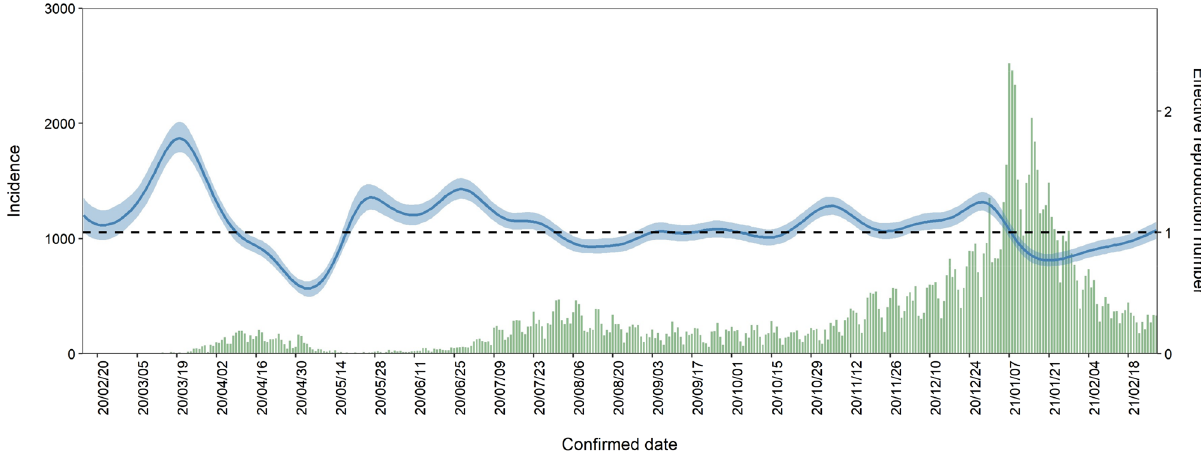
Figure 1. Transmission dynamics from 15th February 2020 to 28th February 2021 in Tokyo, Japan. Blue line represents median, blue shading represents 95% credible intervals of the estimated effective reproduction number from 15th February 2020 to 28th February 2021. Green bars show the observed number of COVID-19 cases with confirmed dates in